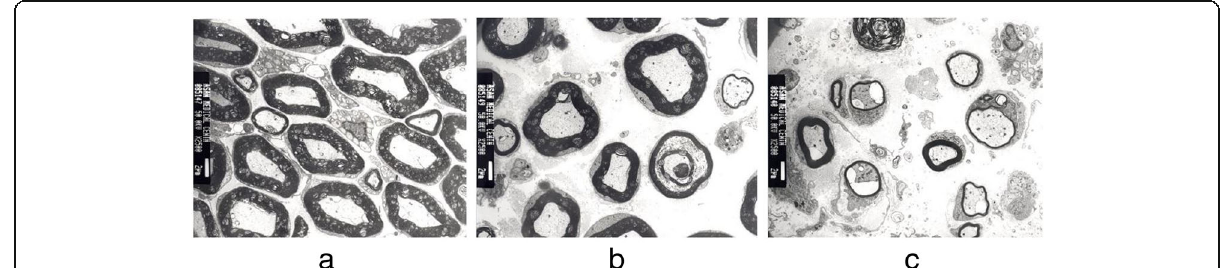
Fig. 6 Transmission electron microscopic photographs showing axonal changes of each group with ×2500 magnification. ( a intact axons and myelins of group A, b atrophic axons and myelins with inter-axonal space of group B, c disintegrated axons with severe atrophic myelins of group C)